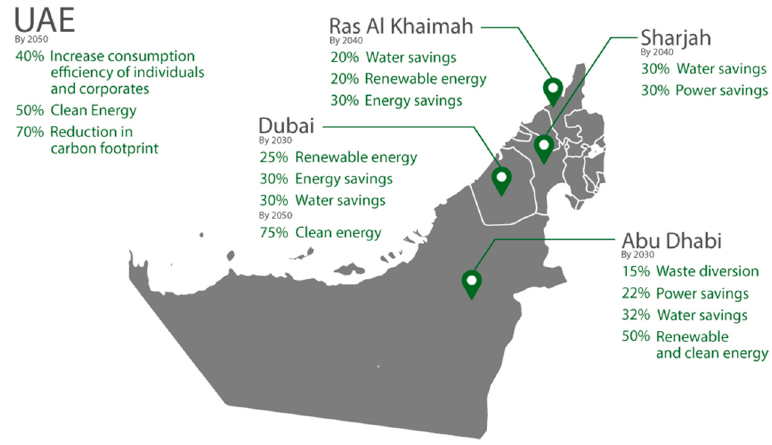
Figure 1. The United Arab Emirates—Sustainability Initiatives (source: EmiratesGBC [8]).